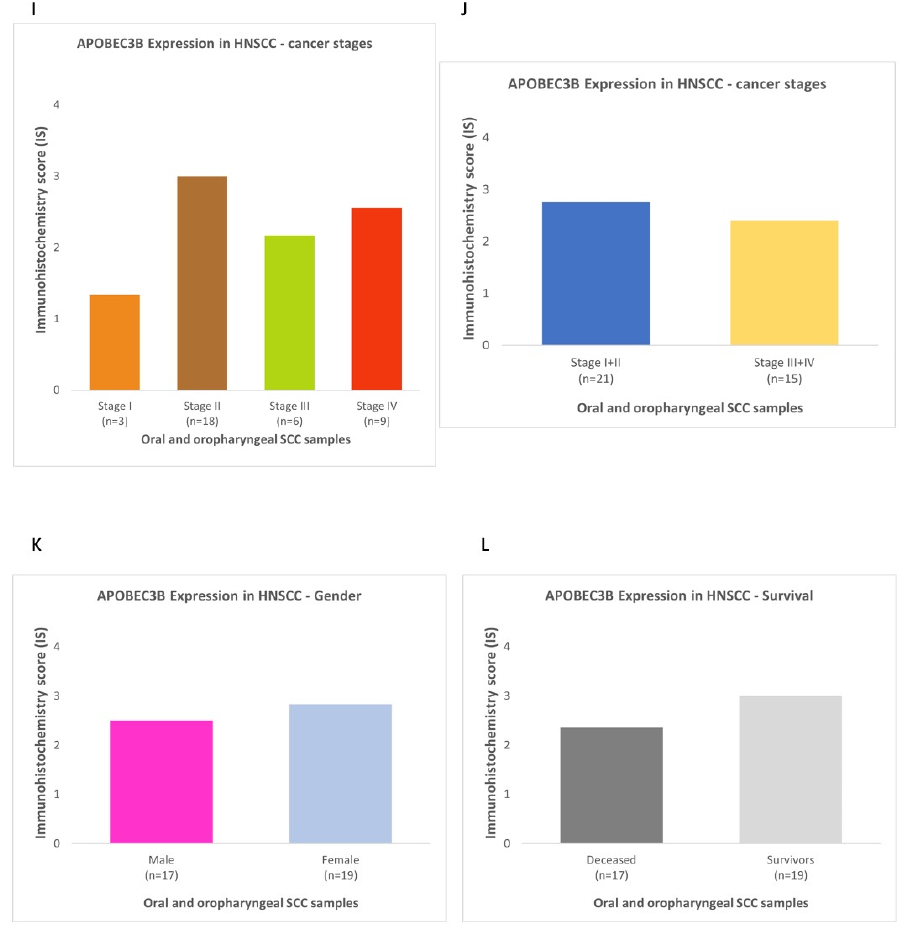
Figure 2. Protein expression of PKC α in oral and oropharyngeal SCC subgroups based on: ( A ) individual cancer stages; ( B ) pooled cancer stages; ( C ) sex; and ( D ) deceased vs. survivors. Protein expression of NF- κ B in oral and oropharyngeal SCC subgroups based on: ( E ) individual cancer stages; ( F ) pooled cancer stages; ( G ) sex; and ( H ) deceased vs. survivors. Protein expression of APOBEC3B in oral and oropharyngeal SCC subgroups based on: ( I ) individual cancer stages; ( J ) pooled cancer stages; ( K ) sex; and ( L ) deceased vs. survivors. (* p < 0.05).